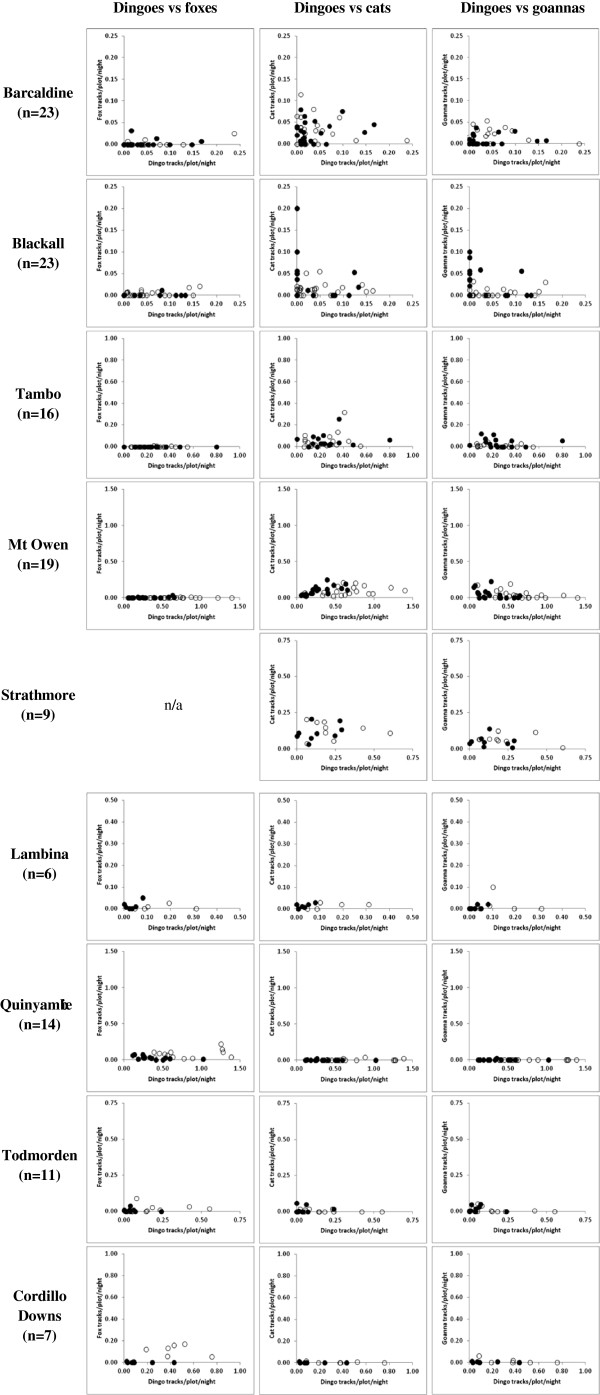
Correlative relationships between dingo and fox, cat and goanna PTI in baited (solid marks) and unbaited (hollow marks) treatment areas at nine sites across Australia, as generated using the approach described by Johnson and VanDerWal [38], but without data transformation, showing the typical absence of triangular relationships amongst sympatric predators.